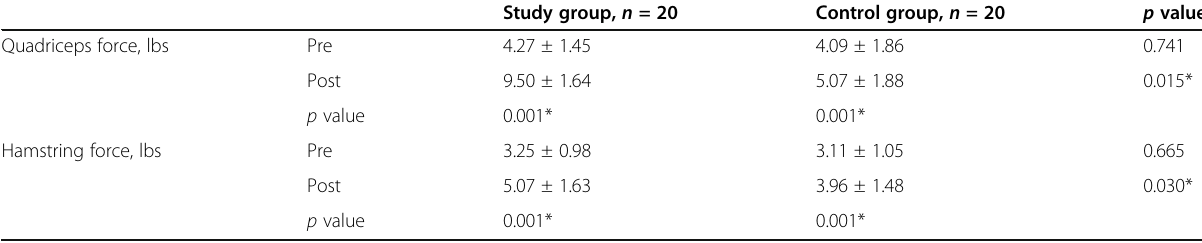
Table 2 The values of quadriceps and hamstring muscle force before and after the